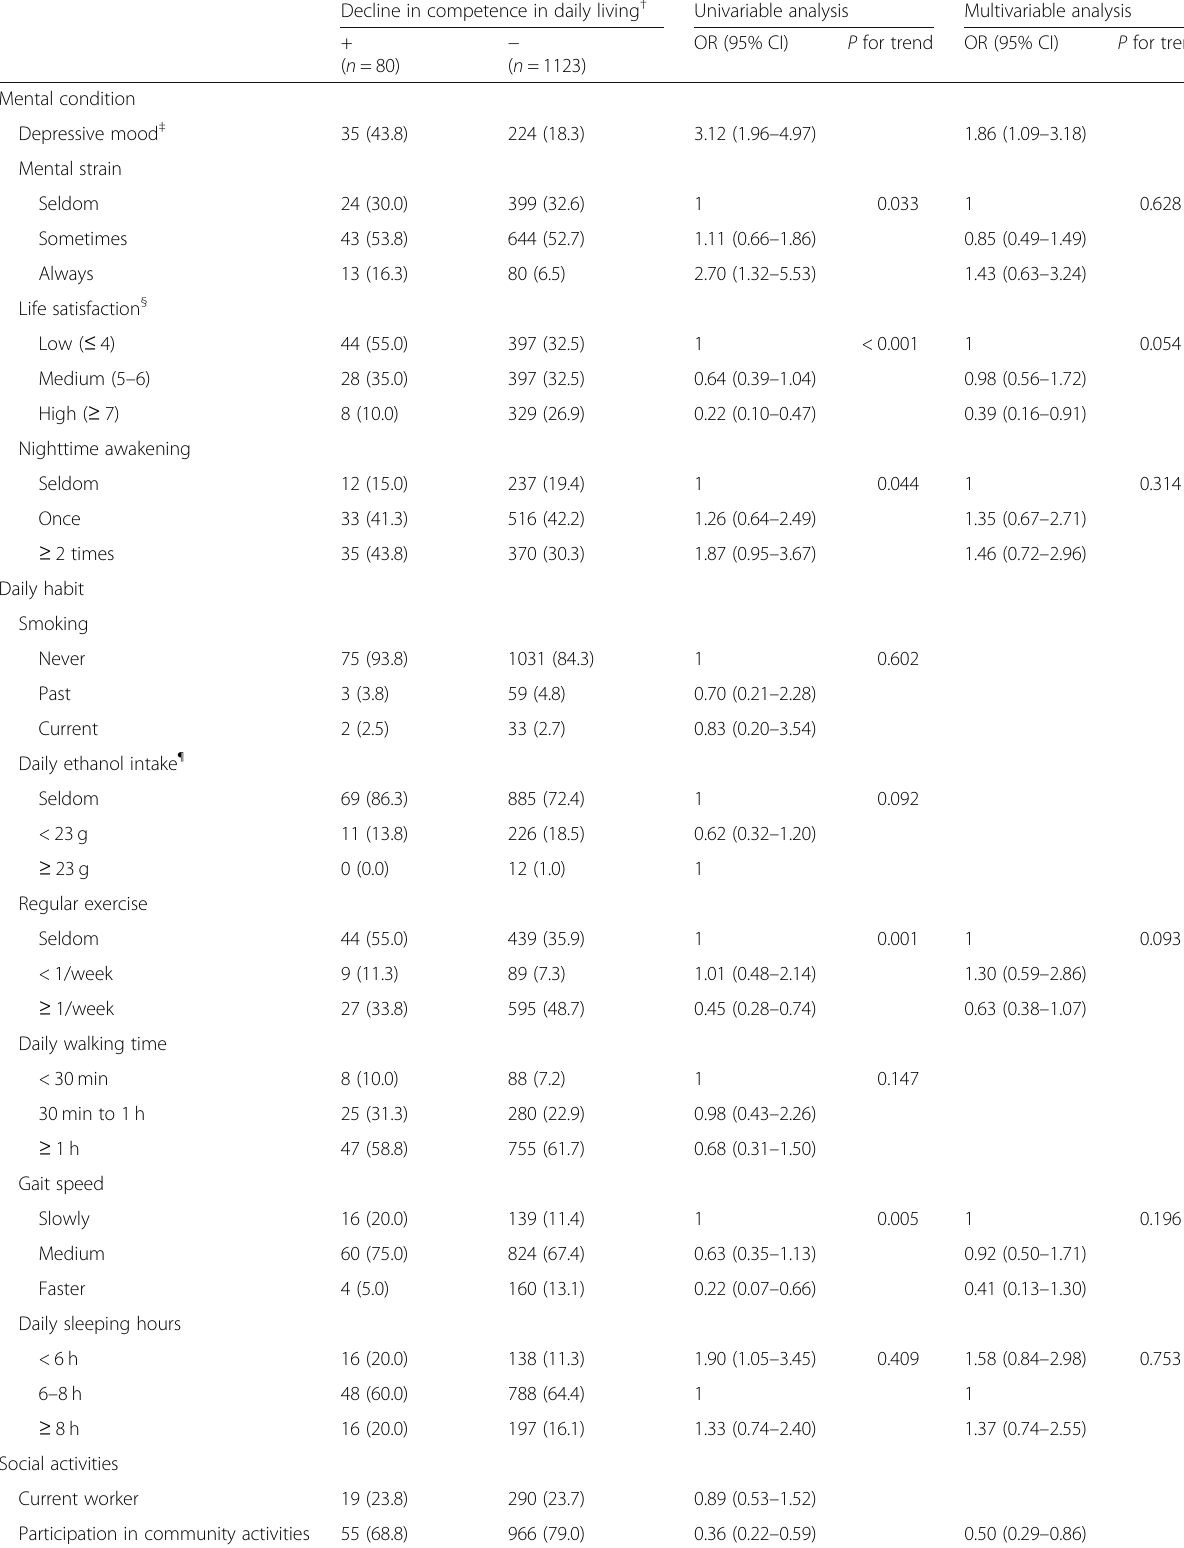
Table 3 Association of lifestyle/psychosocial factors at age 64 years with reduced competence in daily living at age 70 years